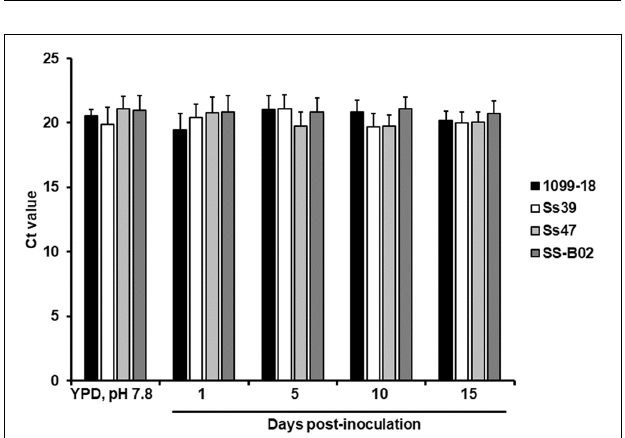
FIGURE 2 | Ct values of genes with putative constitutive and stable expression in S. schenckii sensu stricto growing in different culture conditions. Cells were grown in either Vogel medium, potato-dextrose agar (PDB), brain–heart infusion (BHI), YPD, pH 4.5 (generates hyphae), or YPD, pH 7.8 (generates yeast-like cells) (see Materials and Methods). Total RNA was extracted, cDNA synthesized with oligo(dT) primer (20 mer) and the gene expression was quantified by RT-qPCR using specific primers (see Table 1 ). Only the gene encoding the ribosomal protein L6 showed constant expression in all the tested media. ∗ P < 0.05 when compared to the expression level in hyphae and yeast-like cells.